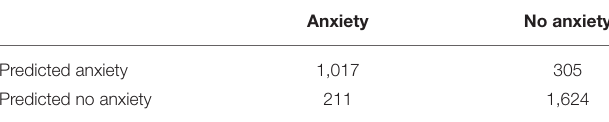
TABLE 1 | The confusion matrix of our prediction model.